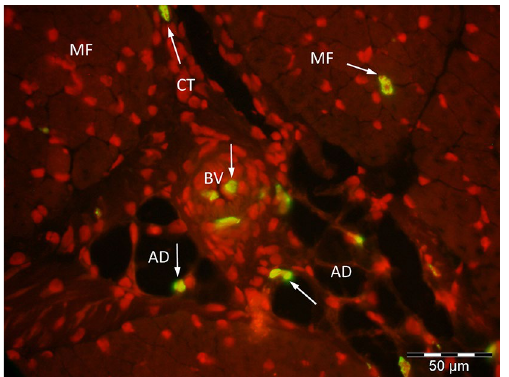
Figure 1. Incorporation of BrdU in proliferating cells within muscle tissue. Immunohistochemical detection of BrdU-positive nuclei (green) and total nuclei (red, stained with propidium iodide) in a longissimus muscle cross section of a 12-day-old piglet. Arrows indicate proliferating cells of different types. MF muscle fibers, AD adipocytes, BV blood vessel, CT connective